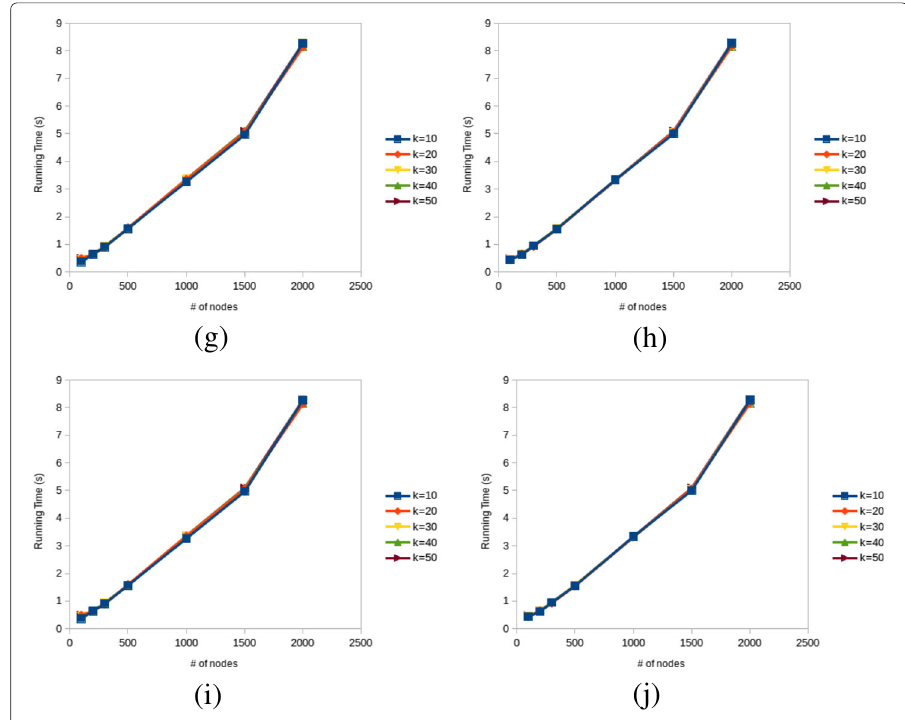
Fig. 8 Scalability evaluation of the proposed methods. g ReProtect on SIS Model. h ReProtect on SIR Model. i ReProtect-p on SIS Model. j ReProtect-p on SIR